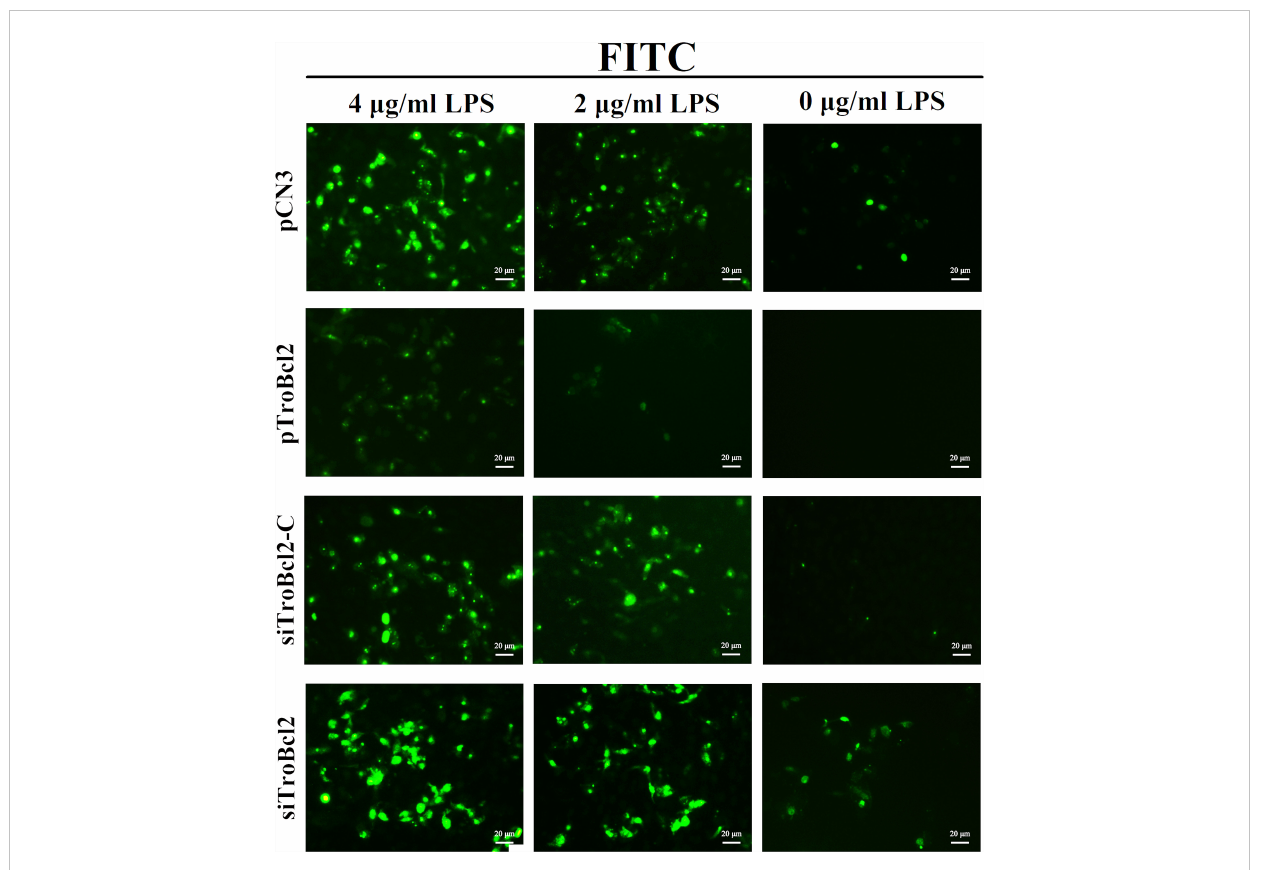
FIGURE 6 Effect of TroBcl2 overexpression and knockdown on LPS-induced apoptosis by TUNEL analysis. GPS cells were transfected with pTroBcl2, pCN3, siTroBcl2, or siTroBcl2-C. Following 24 h transfection, cells were treated with LPS and the apoptotic cells were measured by a TUNEL apoptosis assay kit. The green fl uorescences were observed by inverted fl uorescence microscope